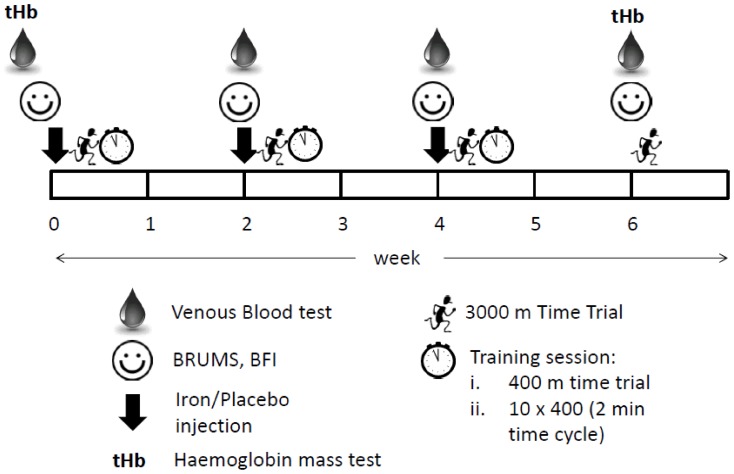
Schematic outline of the study design and testing sessions.BRUMS: Brunel mood Scale; BFI: Brief fatigue Inventory. Weekly injections performed on day 1, followed by 3000 m time trial on day 2 and monitored training session (400 m time trial/10 min recovery/10×400 m) on day 3.